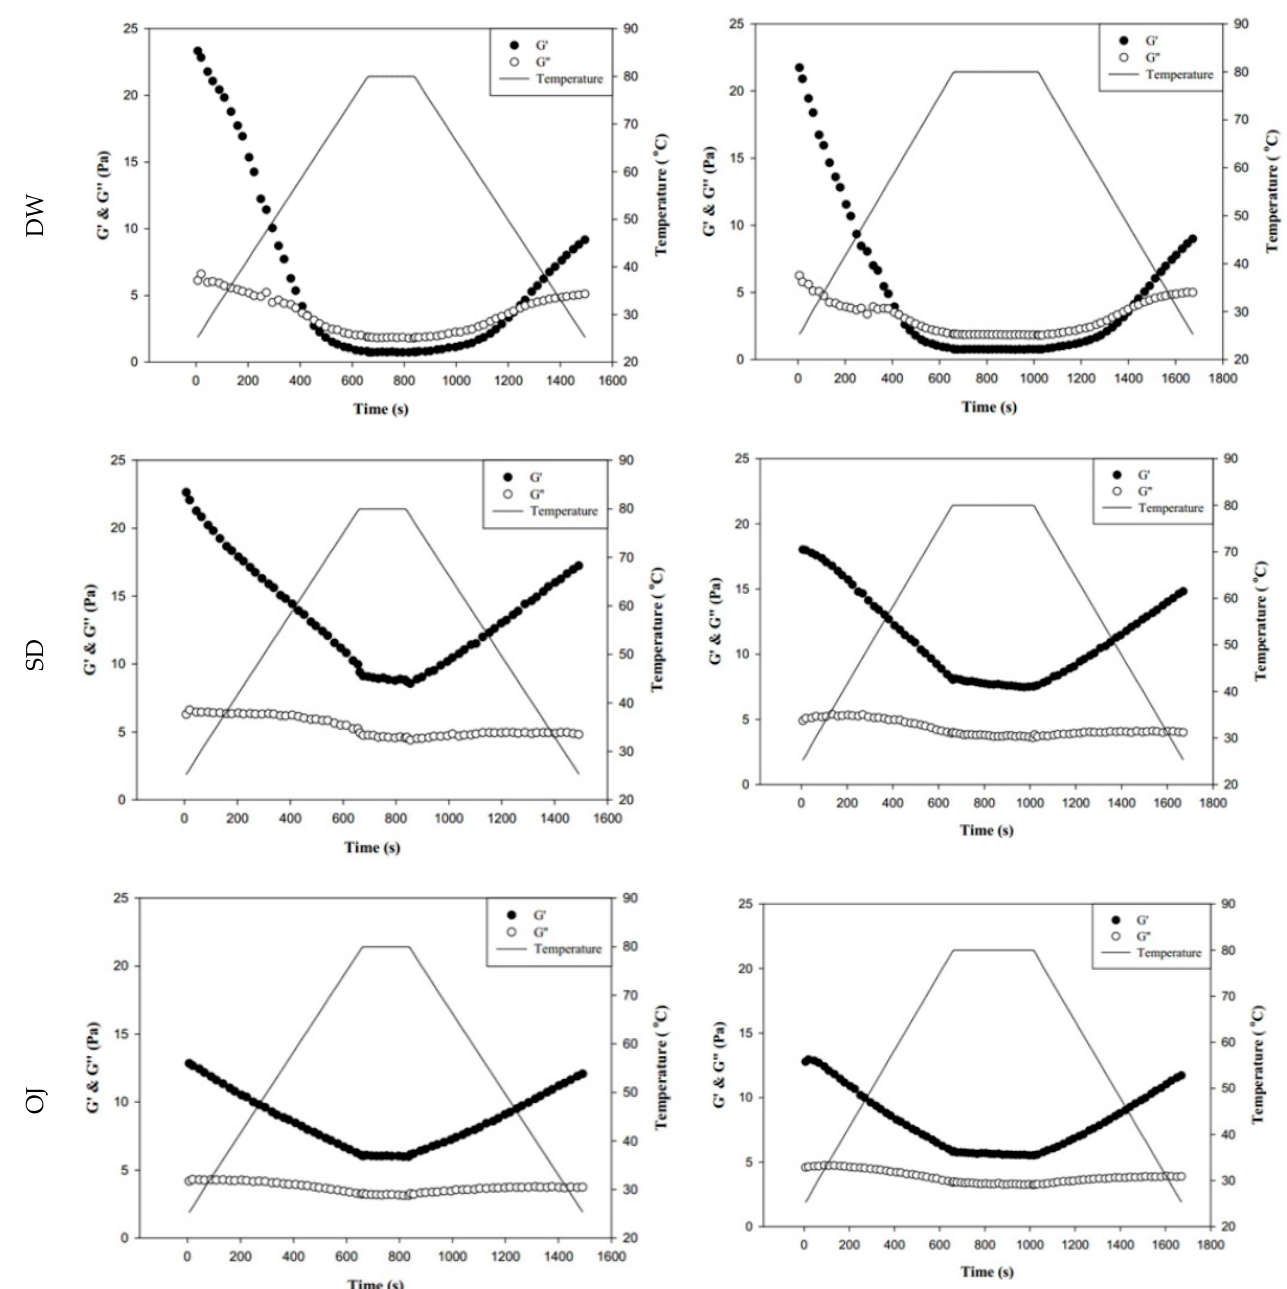
Figure 8. Storage modulus (G ' ) and loss modulus (G '' ) of tapioca starch ( a ), hydroxypropyl distarch phosphate ( b ), and xanthan gum ( c ) with different aquatic contiouous bases and holding times. DW: distilled water; SD: sport drink; OJ: orange juice; 3m: 3 minutes; 6m: 6 minutes. ( ● ): G ʹ ; (o): G ʹʹ ; (—): temperature. ( ▼ ), and ( ▼ ) are signifcantly different at 5% and 1% levels, respectively, between G initial and G end using t-test. For tapioca starch, G’ with ▼ : DW-3m; G“ with ▼ : SD-6m, and OJ-6m; G’ with ▼ : SD-3m, SD-6m, and OJ-6m; G“ with ▼ : DW-6m, SD-3m, and OJ-3m. For, Hydroxypropyl distarch phosphate. G’ with ▼ : SD-6m. For xanthan gum. G“ with ▼ : SD-6m; G‘ with ▼ : DW-3m, and DW-6m.